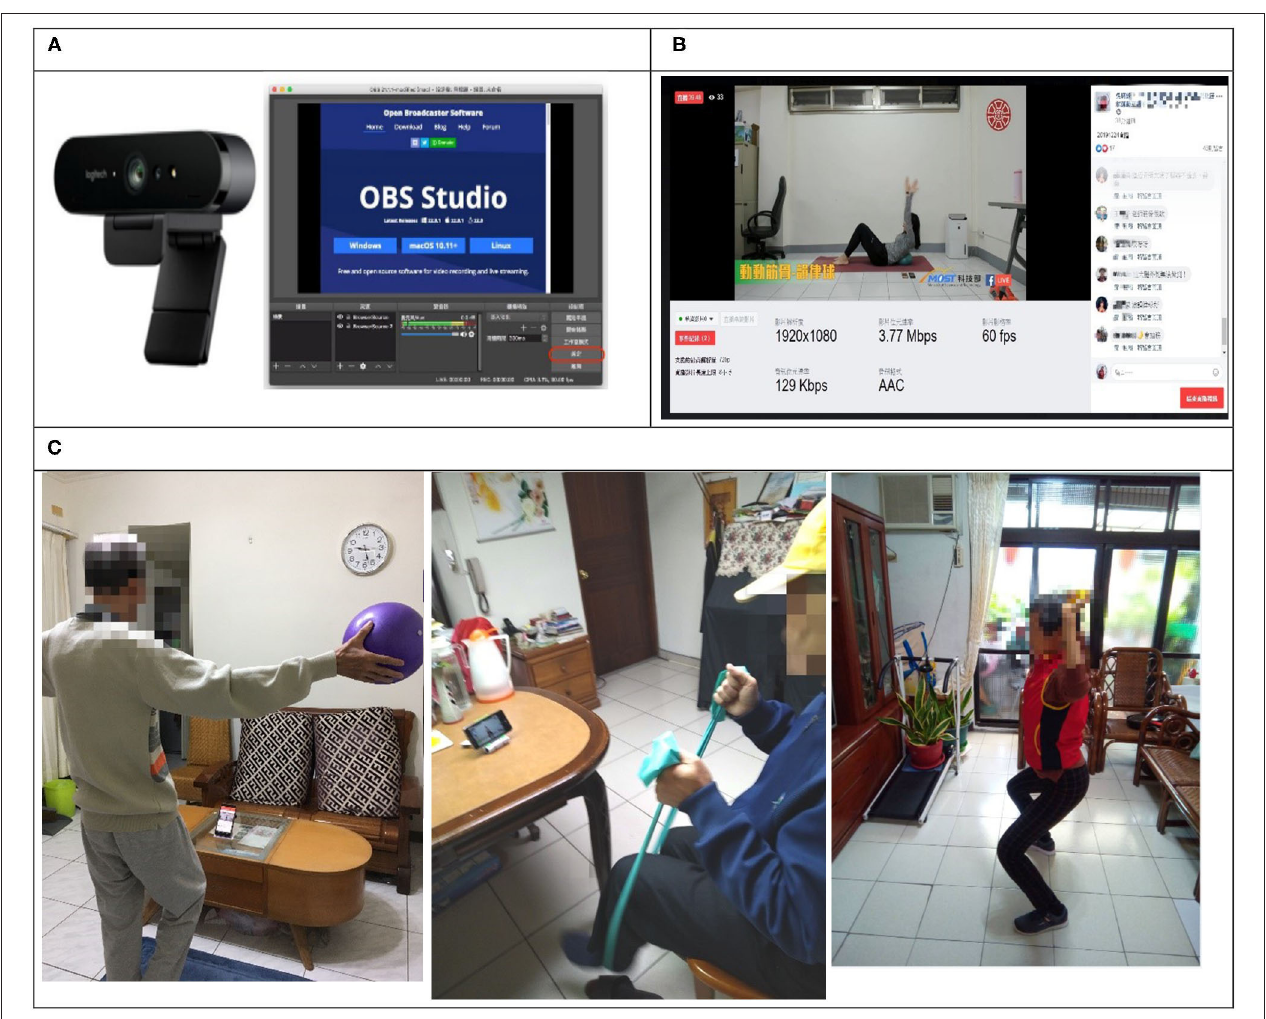
FIGURE 1 | Facebook remote live-streaming-guided exercise. (A) Equipment and software for live-streaming exercises. (B) Instructor’s remote exercise conferencing display. (C) Pictures of participants following the instructor’s